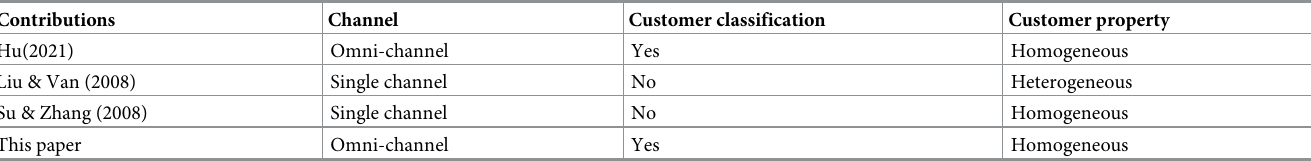
Table 1. Classification of main